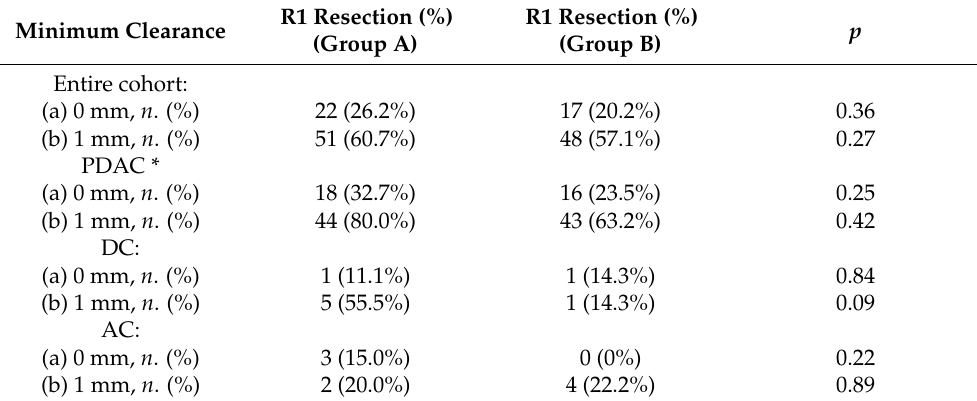
Table 2. R1 resection rate in both study’s groups, adopting 0 mm and 1 mm